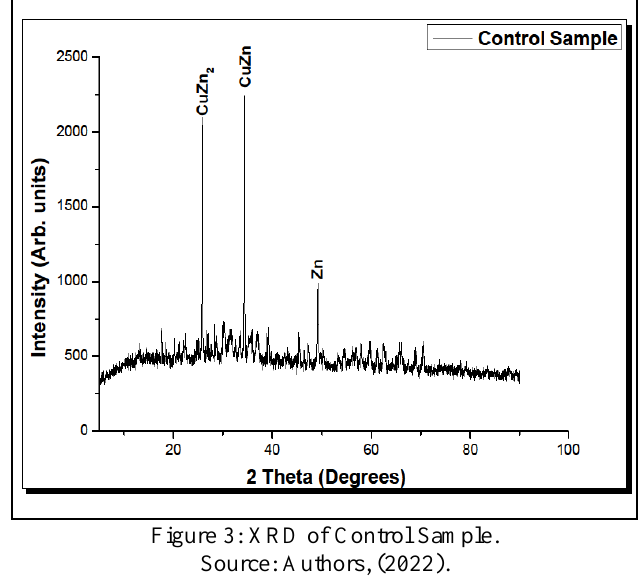
Figure 3: XRD of Control Sample.